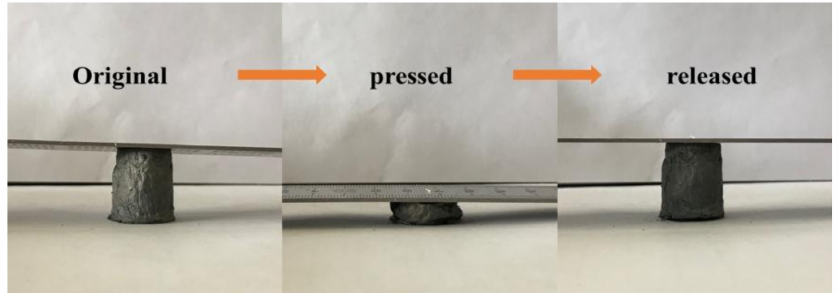
Figure 5. Compression and resilience of graphene/CNTs.